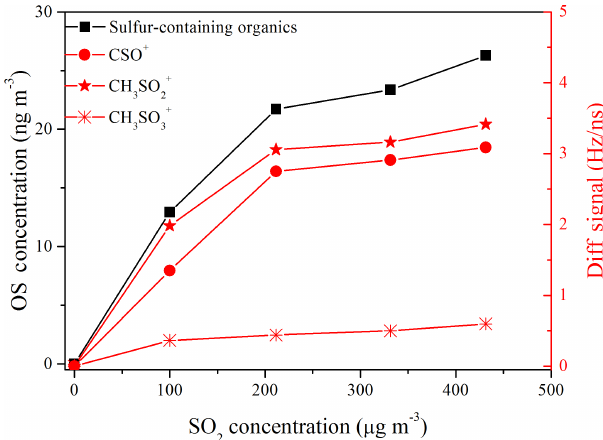
Figure 4. Relationship between SOA concentration (left y axis), corrected SOA yield (right y axis), and H + concentration, which was used to characterize the particle acidities. The H + concentra- tion presented in this plot was the value when the SOA formation rate reached the peak during each experiment (Exps. SGN1, SGN2, SGN3, and SGN4).